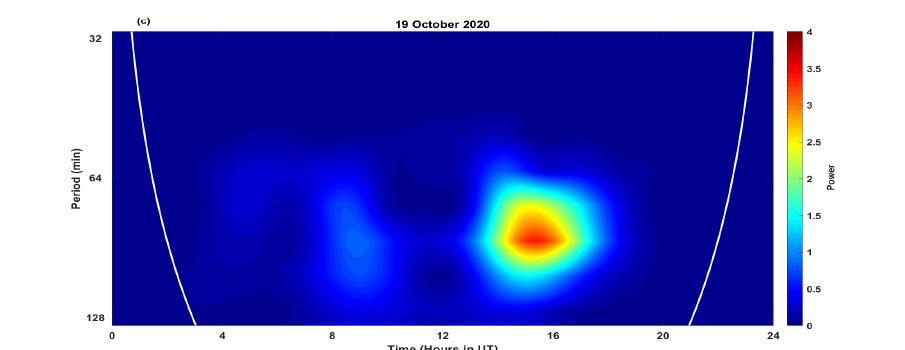
Figure 9. Diurnal variation of ( a ) VTEC (top), ( b ) dVTEC (middle), and ( c ) scalogram (bottom) for 19 October 2020. In the top panel, the black solid curve and the red dotted curve represent the observed and fitted TEC profiles, respectively.